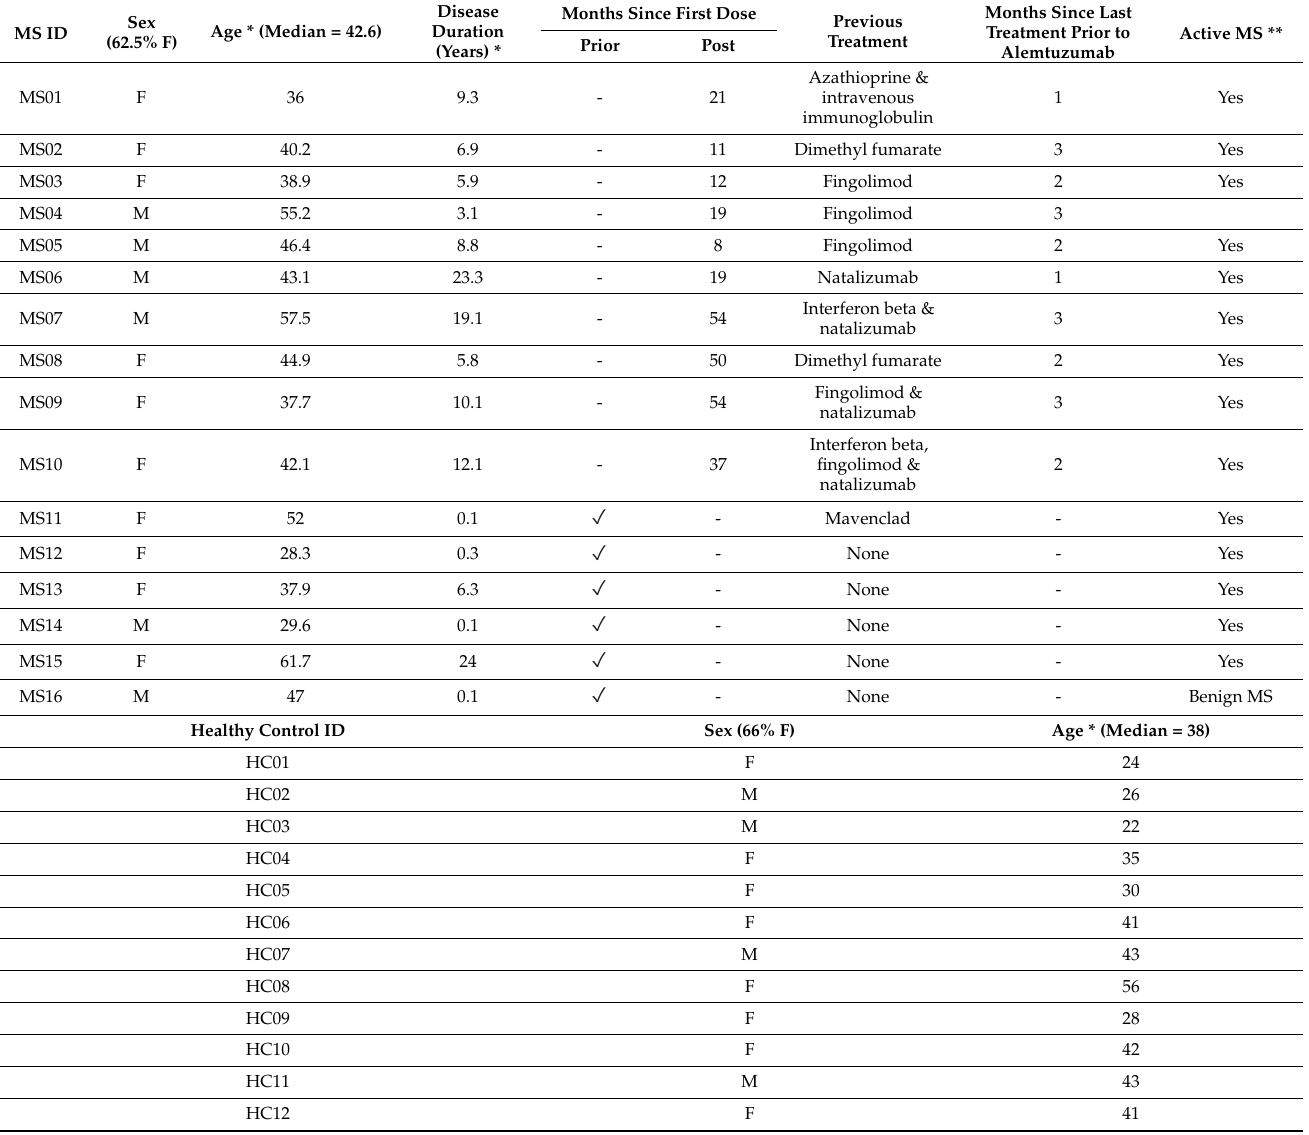
Table 1. Demographic and clinical characteristics of study participants.